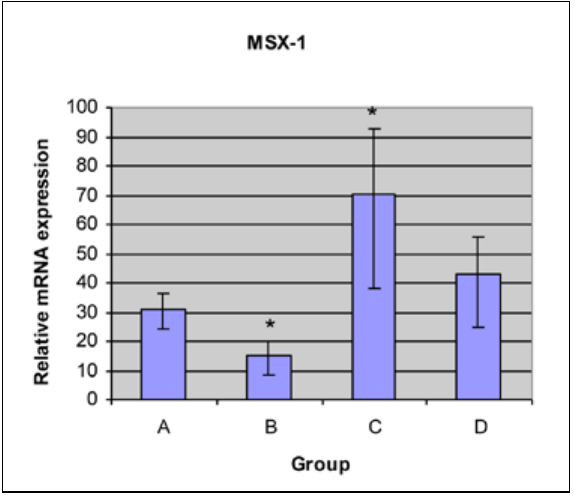
Figure 2. Expression of Pax-7 by human embryonic stem cells – Day 8 ( * p < 0.05). Late addition of BMP4 (Group B) significantly different to SDIA, alone (group A). * p < 0.05, reflecting a significant difference between the means of the groups.